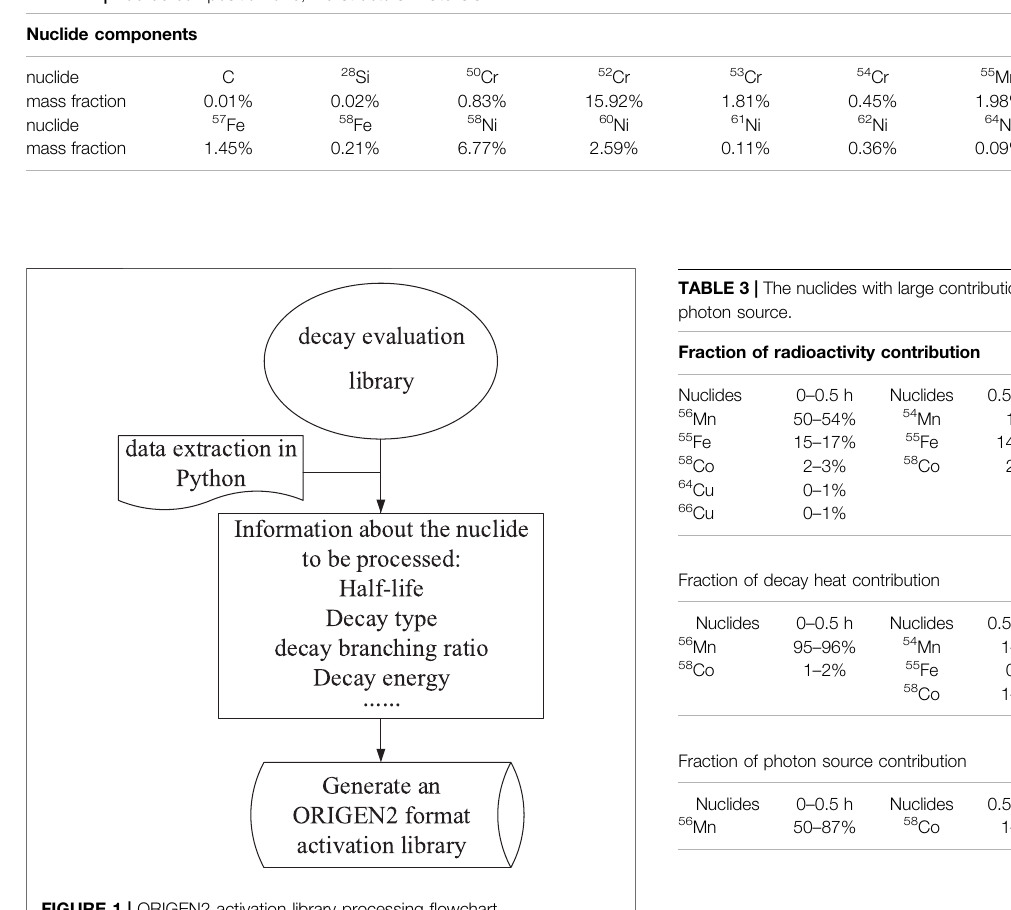
FIGURE 1 | ORIGEN2 activation library processing fl owchart.